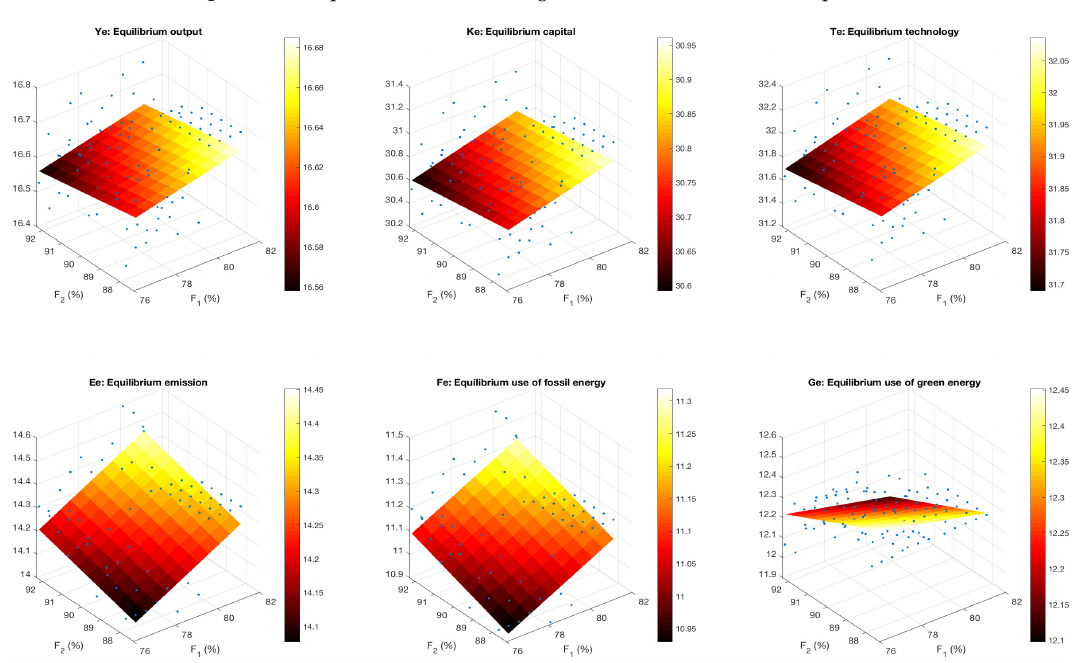
Figure A11. Equilibrium values on grid, OECD countries: fitted planes.